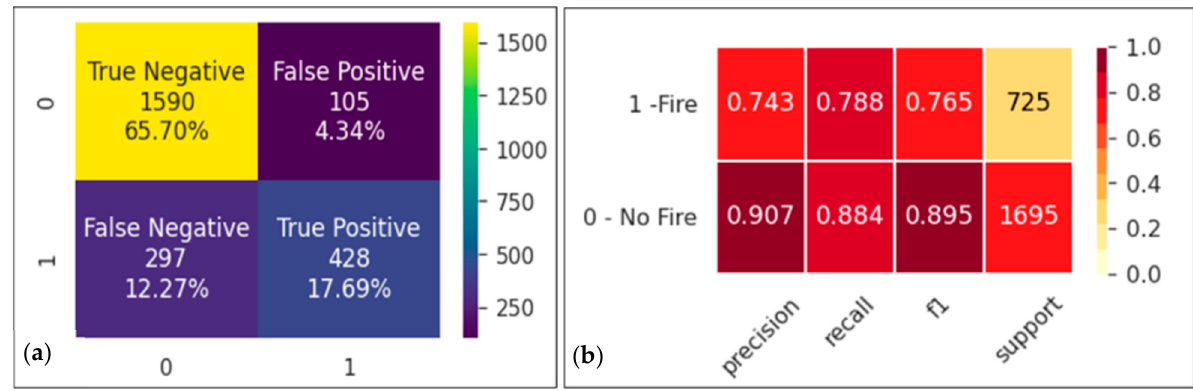
Figure 7. Final Ensemble model (Adaboost)—Scalability ( a ), Learning Curve ( b ) on Training examples, Performance Curve ( c ), and Evaluation metrics ( d ).